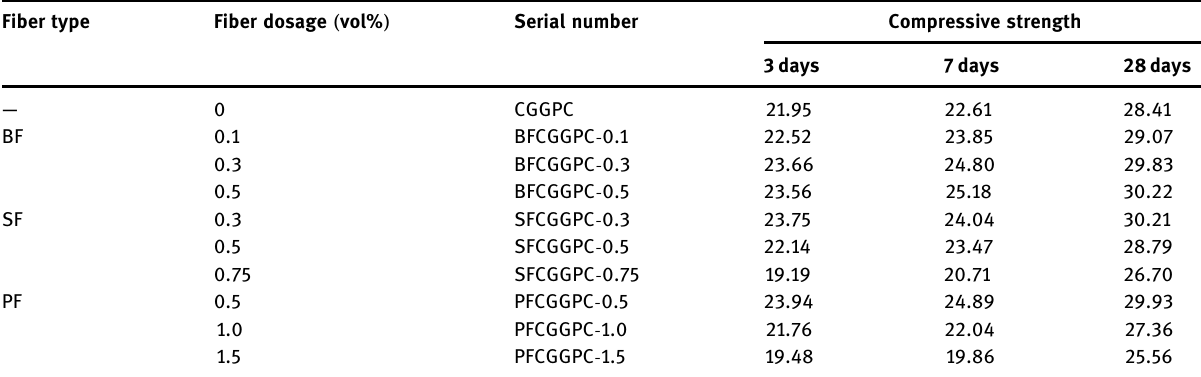
Table 7: Test results of cube compressive strength